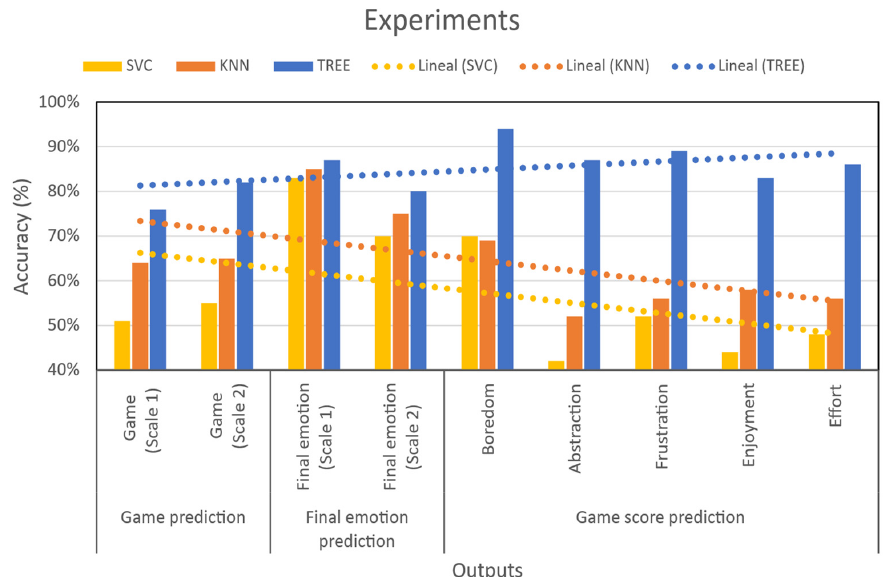
Figure 12. Results of the different types of machine learning classification used in the experiments.